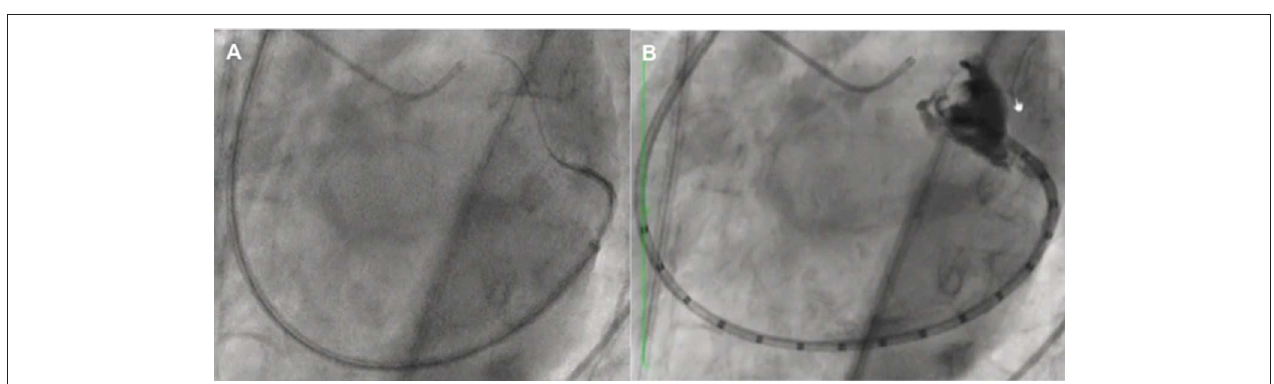
FIGURE 4 | Uncontrolled hydrophilic wire advancement (A) leading to coronary sinus perforation (B) .